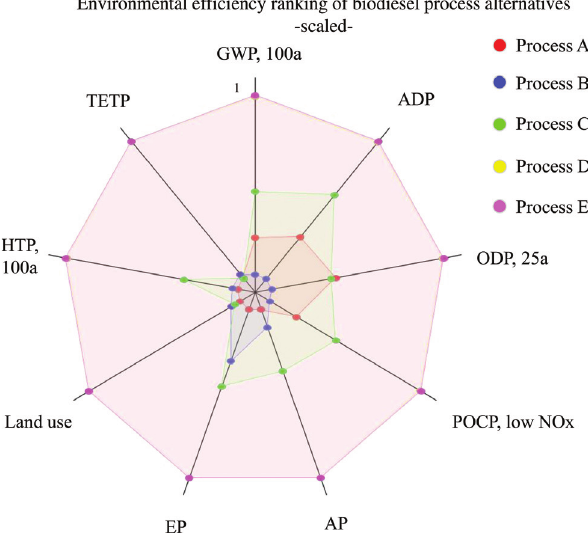
Figure 12 Comparison of production costs for different biodiesel production alternatives (Process A: pretreated alkali-catalyzed; Process B: acid-catalyzed; Process C: heterogeneous acid-cat- alyzed; Process D: supercritical process, all published by West et al. [42] and Process E: supercritical process developed within CoPIRIDE) feedstock in all cases: waste vegetable